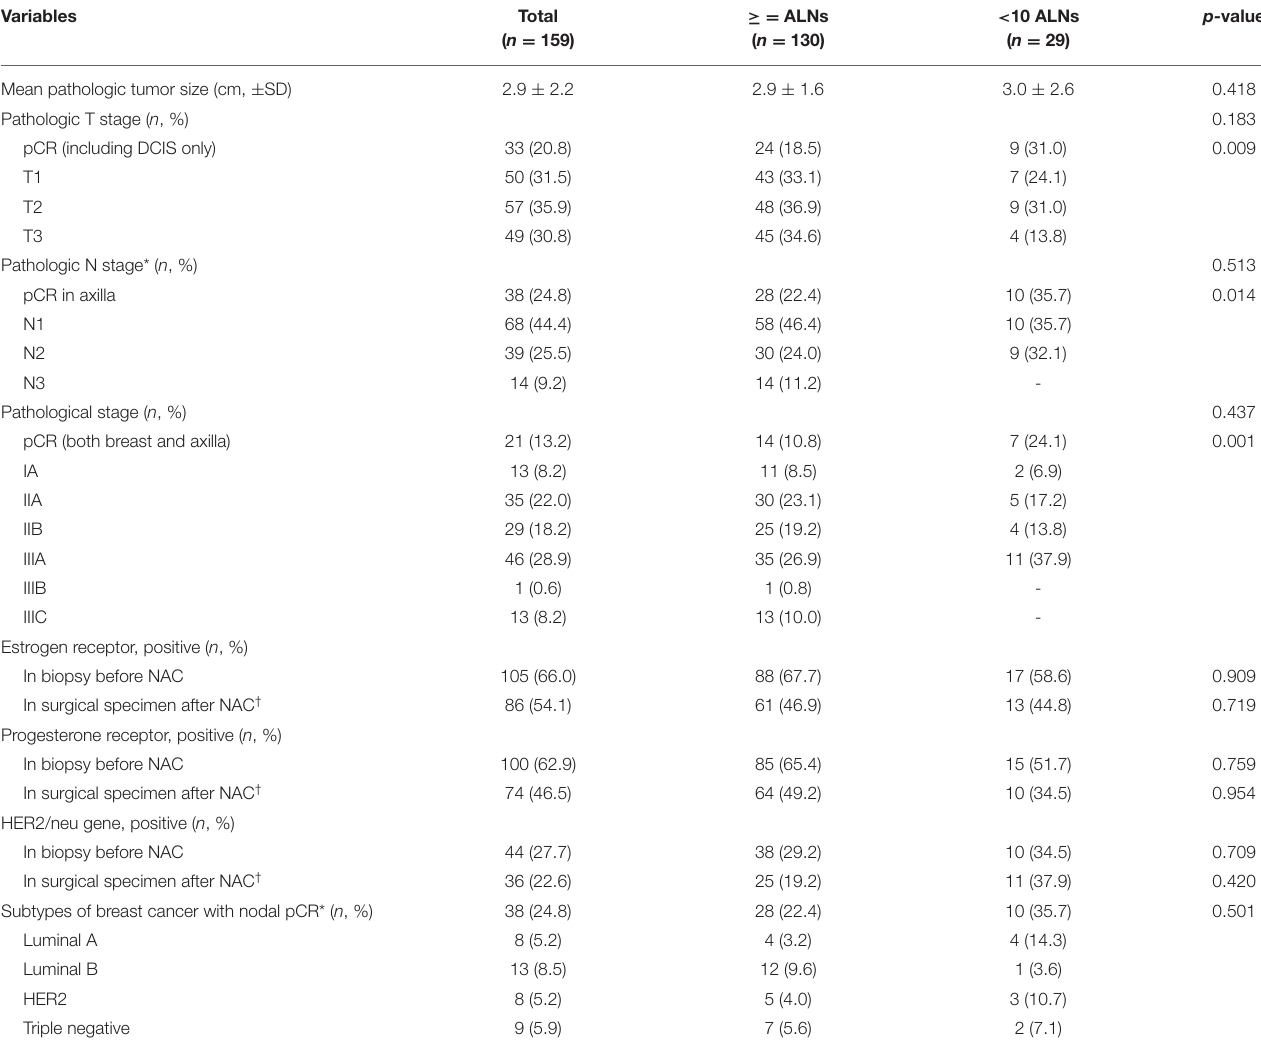
TABLE 2 | Pathologic results of patients with breast cancer who received axillary lymph nodes dissection followed by neoadjuvant chemotherapy.